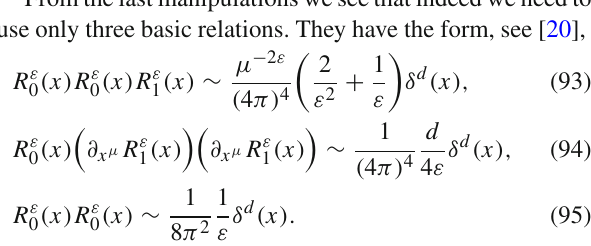
The last additional terms can not be considered, because they are from the ZM -term, and therefore, according to the results of the paper [57], they are not affecting the divergent part of the two-loop